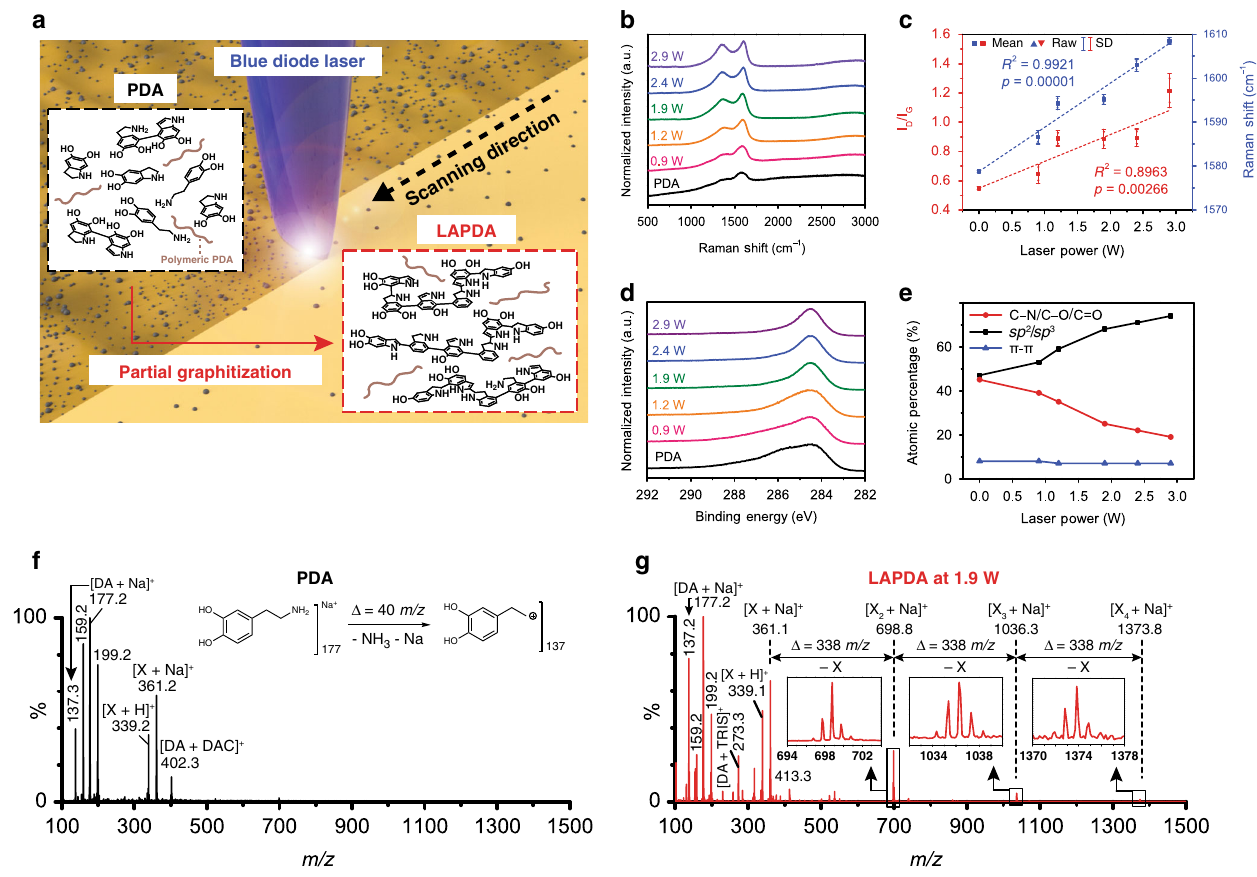
Fig. 1 Partial graphitization of PDA fi lm by BLA process for mechanical enhancement. a Schematic of the BLA process in which pristine PDA fi lm is raster-scanned by laser light. Graphitization level of each LAPDA fi lm was characterized by b, c Raman and d, e X-ray photoelectron spectroscopies. Rectangular, triangular marks, and error bars in Fig. 2c represent mean values, original data points, and standard deviation, respectively. MALDI-TOF molecular mass of f PDA fi lm and g LAPDA fi lm at 1.9 W. The delta (uppercase) means a mass change. Source data are provided as a Source Data fi